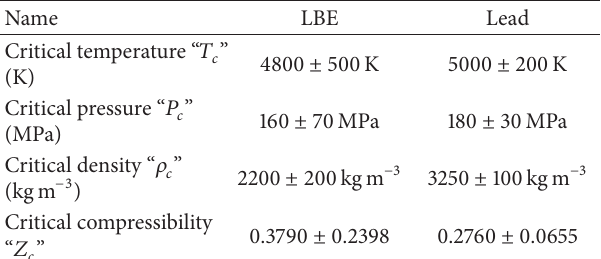
Table 3: The LBE and Lead critical